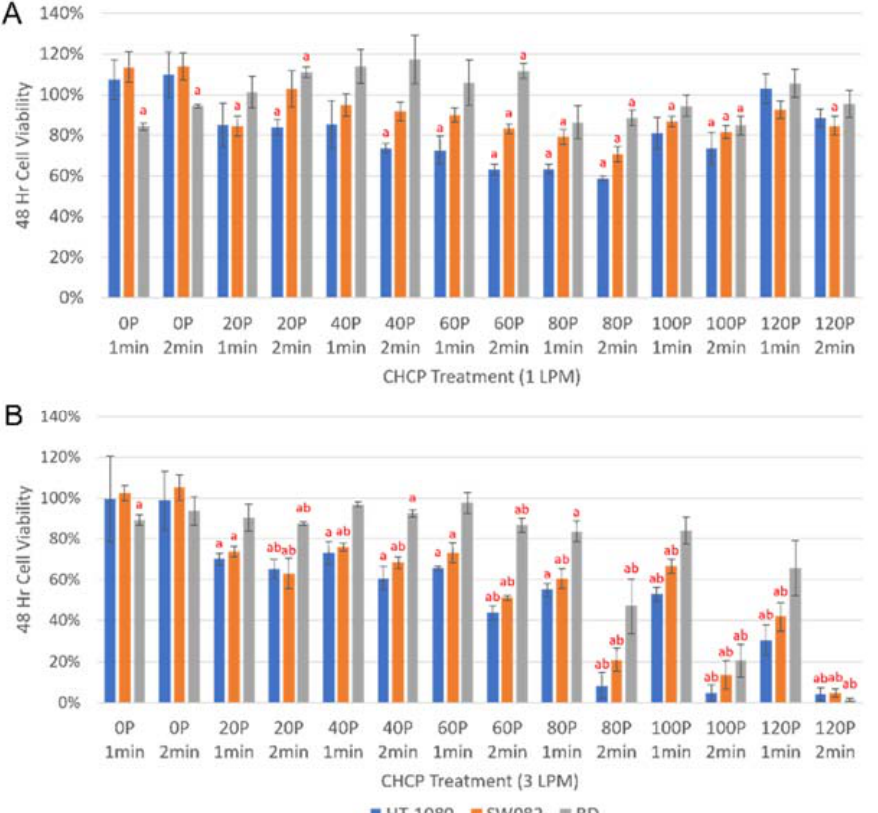
Figure 1. Bar graph showing the cell viability of HT-1080, SW982, and RD cells 48-h post-CHCP treatment compared to mock controls. Cells were seeded in 96-well plates at a concentration of 5 × 10 3 cells/well and treated with ( A ) 1 or ( B ) 3 LPM at 20–120 P for 1–2 min. Helium alone (0 P) did not significantly impact HT-1080 or SW982 cell viability. CHCP significantly reduced HT-1080 and SW982 viability at all 3 LPM tested doses and RD viability at most 3 LPM tested doses compared to mock controls. Statistical significance for CHCP versus mock controls ( a p ≤ 0.05) and 1 LPM versus 3 LPM CHCP treatment ( b p ≤ 0.05) were considered.